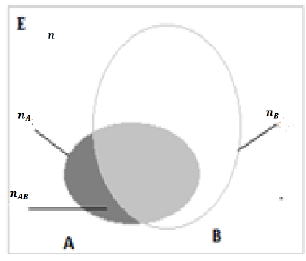
Figure 1. The Venn diagram of the SIA presentation. For example, with two datasets of 9 objects described by 3 variables as Figure 2, the implication relationship between two variables (movies) Toy Story (1995)  Star War (1997) is (9, 5.2, 7.8, 0.72) if variables are in the quantitative form and (9, 7, 8, 1) if variables are in the binary form.